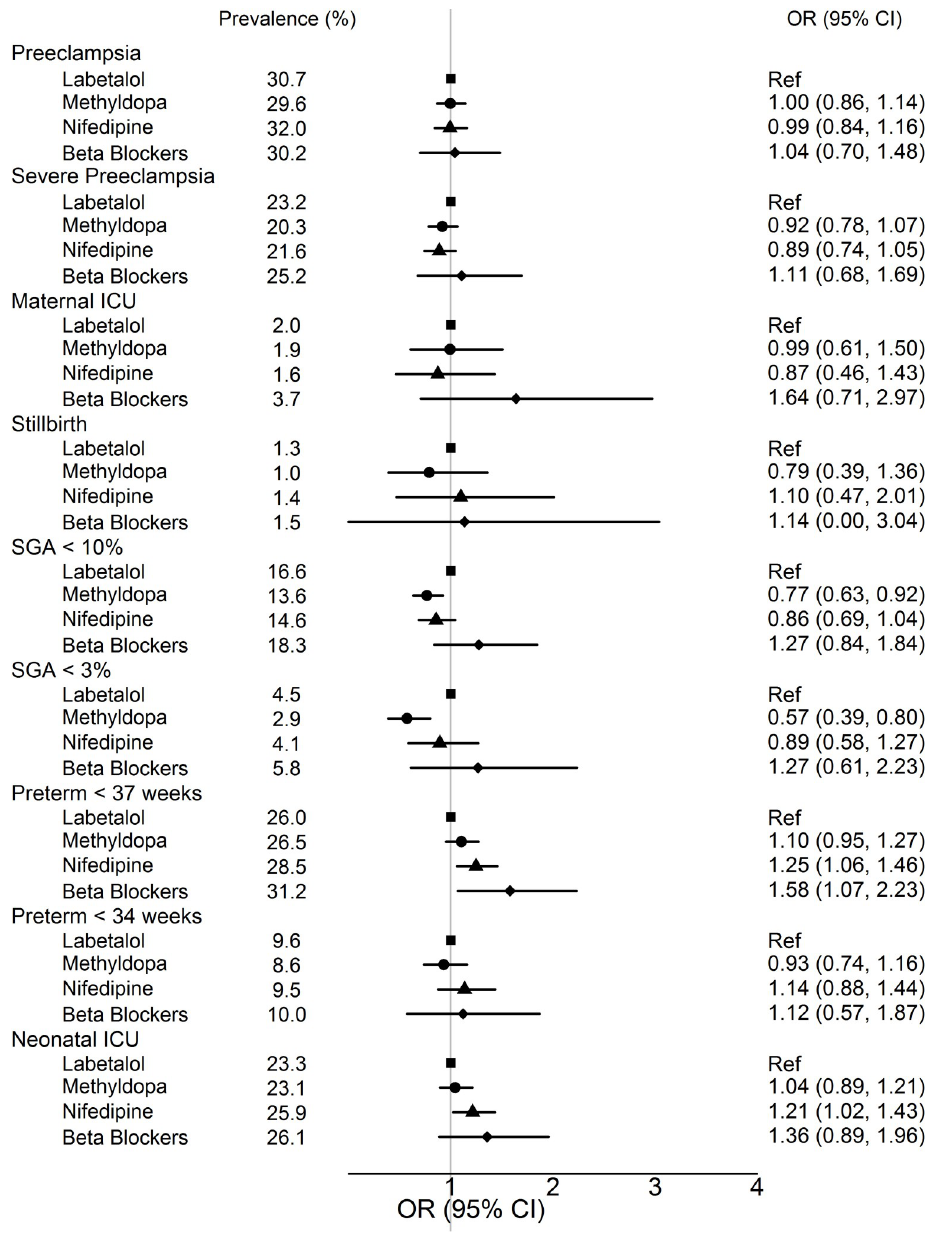
Fig 2. Risk of maternal and neonatal outcomes with use of different antihypertensive medications in pregnancy � . Abbreviations: OR, odds ratio; CI, confidence interval; SGA, small for gestational age; ICU, intensive care unit. � ORs and 95% CIs are calculated after inverse probability of treatment weighting. Labetalol is the referent group. The population for different outcomes differs slightly because pregnancy losses were not included in the denominator for SGA, preterm delivery, or neonatal ICU admission. For most outcomes, the total N is 6346, for SGA the total N is 6240, and for preterm delivery and NICU admission the total N is 6272. �� Weighted prevalence in the subgroup, calculated using inverse probability of treatment weighting with unstabilized